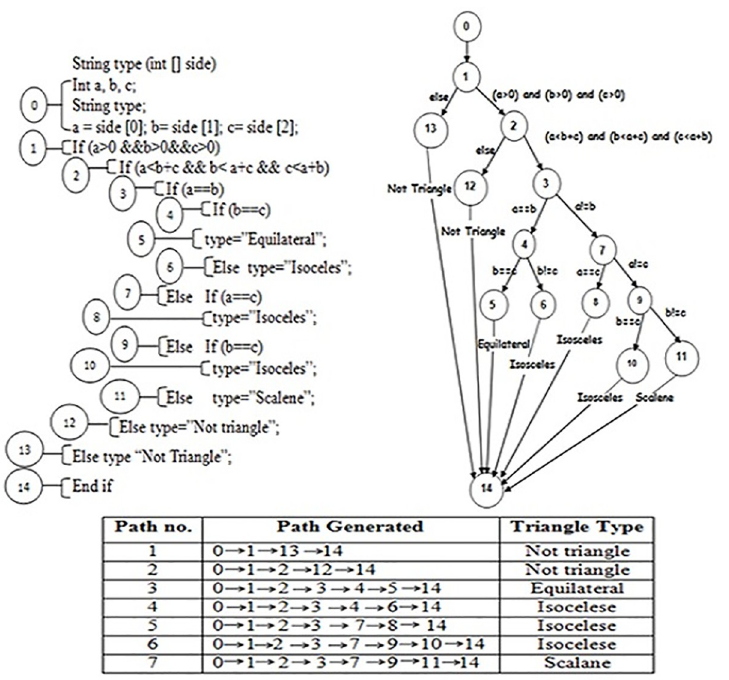
Fig 5. The code and the control flow graph of triangle classification